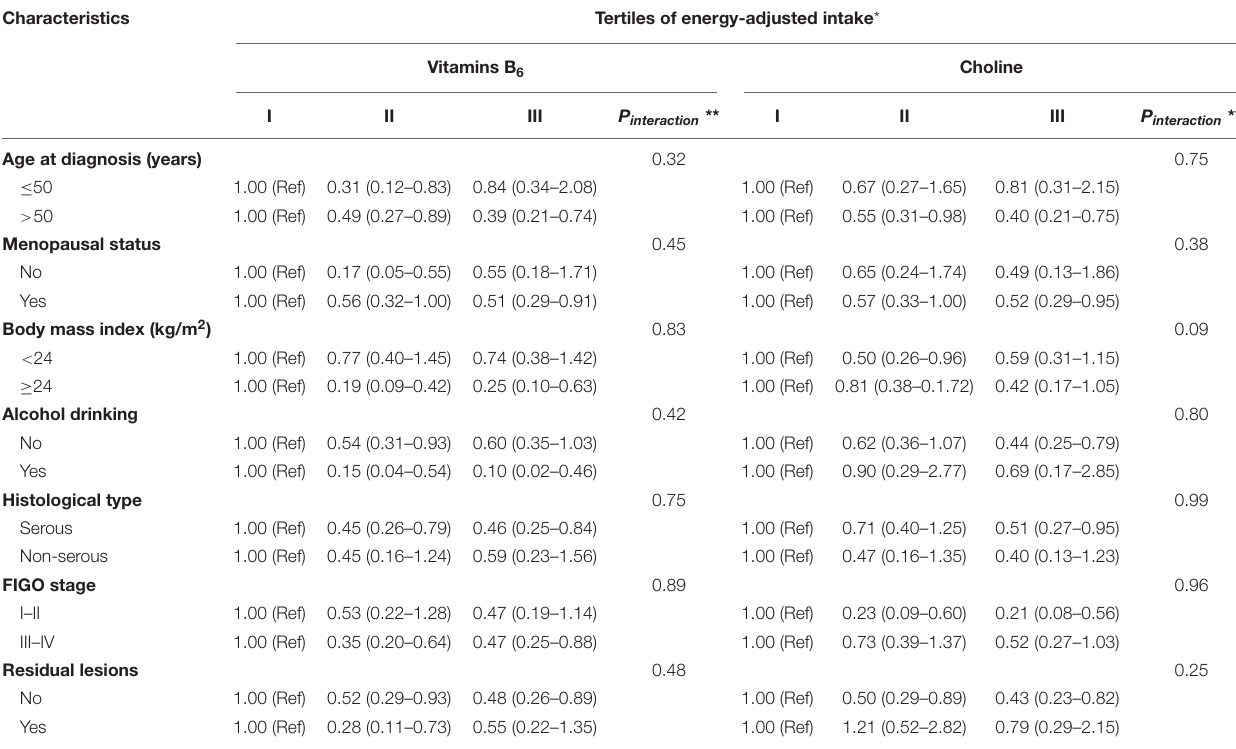
CI, confidence interval; HR, hazard ratio; Ref, reference. *Adjusted for energy by the residual method. **Test for interaction based on strata and dietary vitamin B6 and Choline intake. HR and 95% CI were calculated with the use of the Cox proportional hazards regression model with adjustment for age at diagnosis, body mass index, total energy, alcohol drinking, diet change, education, income, physical activity, menopausal status, parity, multivitamin use, multimineral use, red meat, methyl-donor index, comorbidities, FIGO stage, histological type, histopathologic grade, and residual lesions.